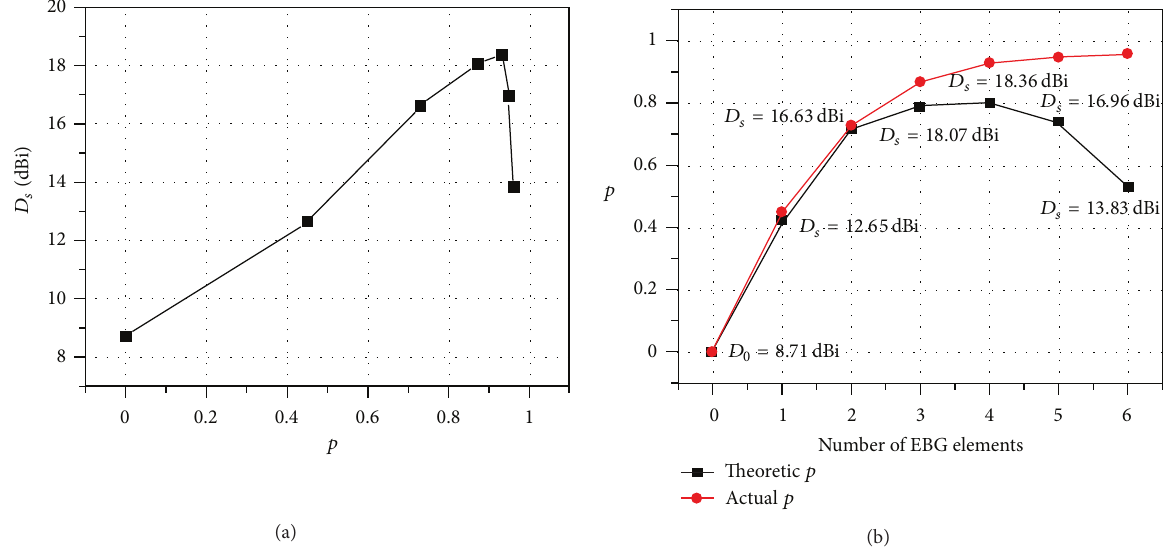
Figure 4: (a) Simulated directivity of the antenna with EBG superstrates versus different 𝑝 , (b) comparison between the theoretic 𝑝 calculated by (10) and the actual 𝑝 realized by various EBG